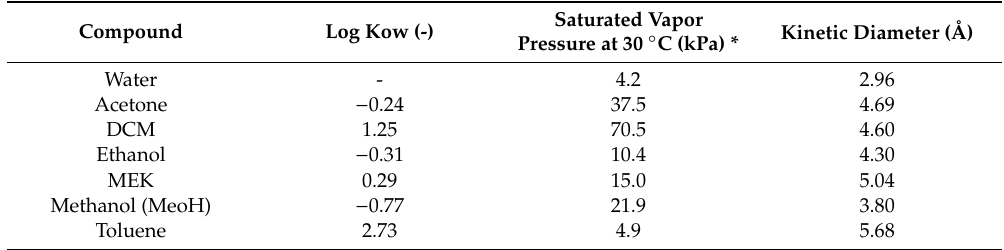
* estimated with the Antoine’s